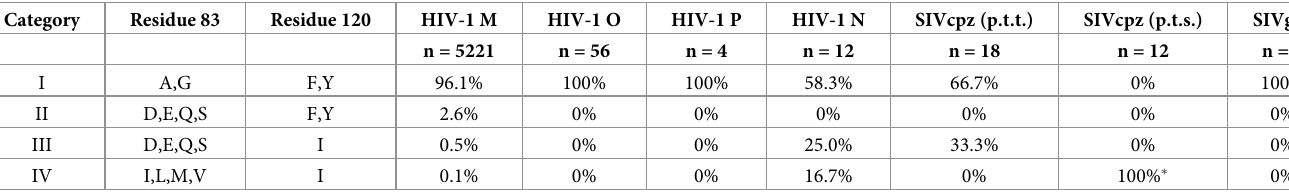
Altogether, 5329 HIV-1, SIVcpz, and SIVgor Nef sequences were classified into four categories (I–IV) based on the side chain properties of residues 83 and 120 as indicated. Individual HIV-1 M Nef proteins evading this classification could be found, but showed frequencies < 0.05%. � Instead of Ile, some SIVcpz(P.t.s.) proteins contain Val at position